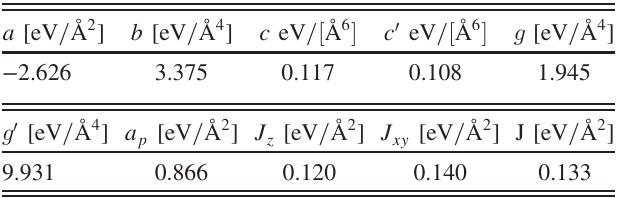
TABLE I. Landau parameters from Ref. [21] and the derived nearest-neighbor coupling terms in this